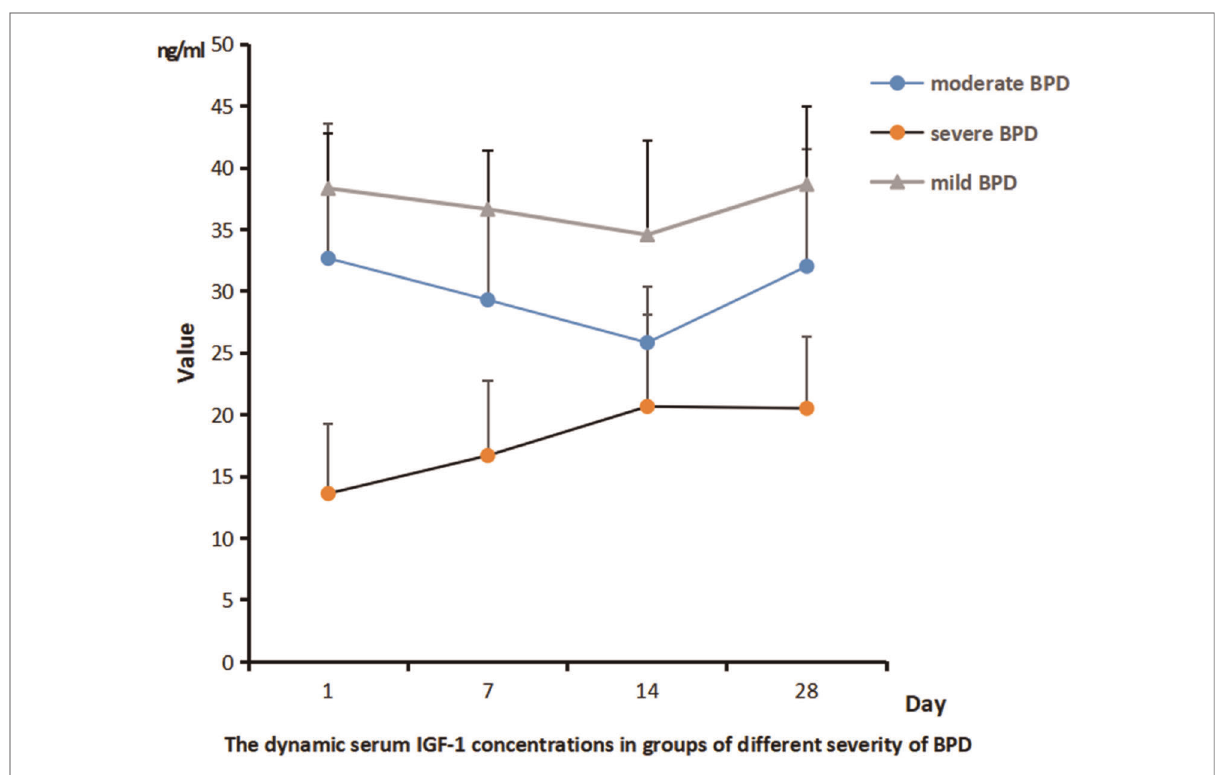
FIGURE 3 The dynamic serum IGF-1 concentrations in groups of different severity of